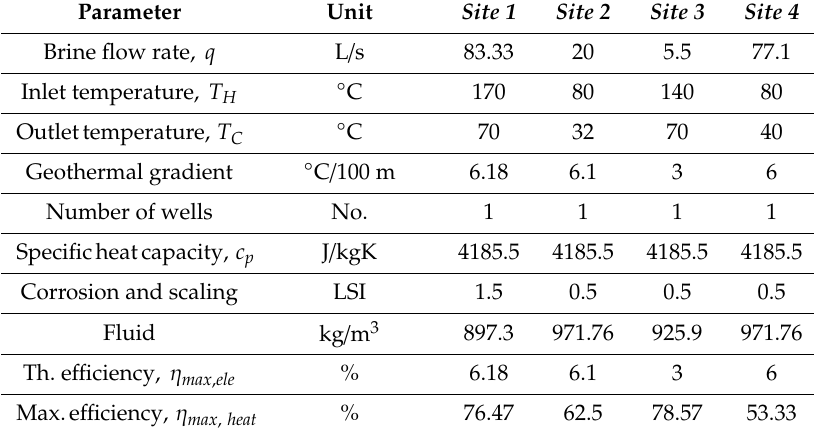
Table 13. Input parameters for the multiple-criteria decision-making (MCDM) matrix for four selected geothermal sites.